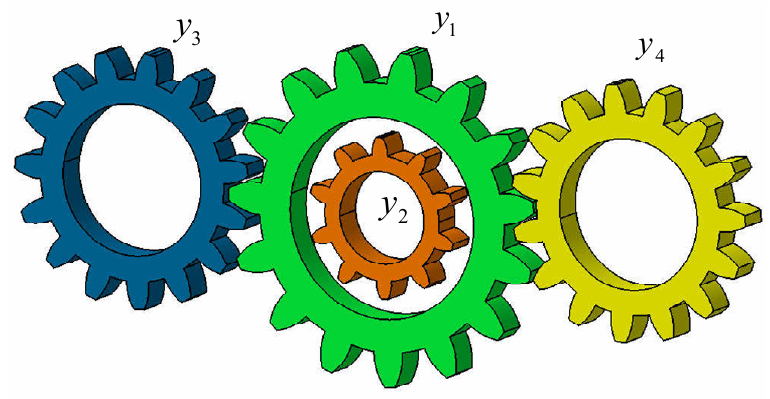
Figure 9. Gear train design problem.